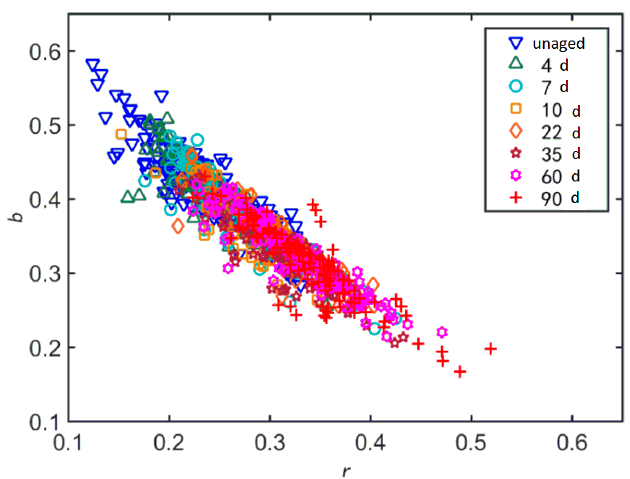
Figure 5. r , b values of chromatic dispersion images for fibers under different aging stages.